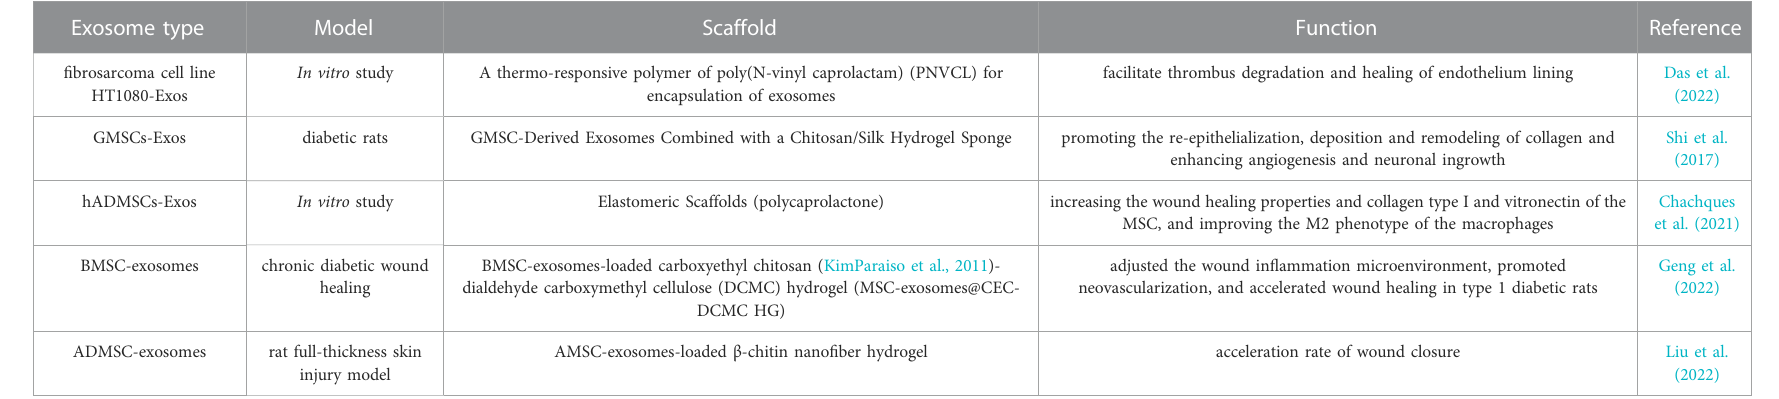
TABLE 2 Summary of research concerning exosome-loaded scaffold in wound